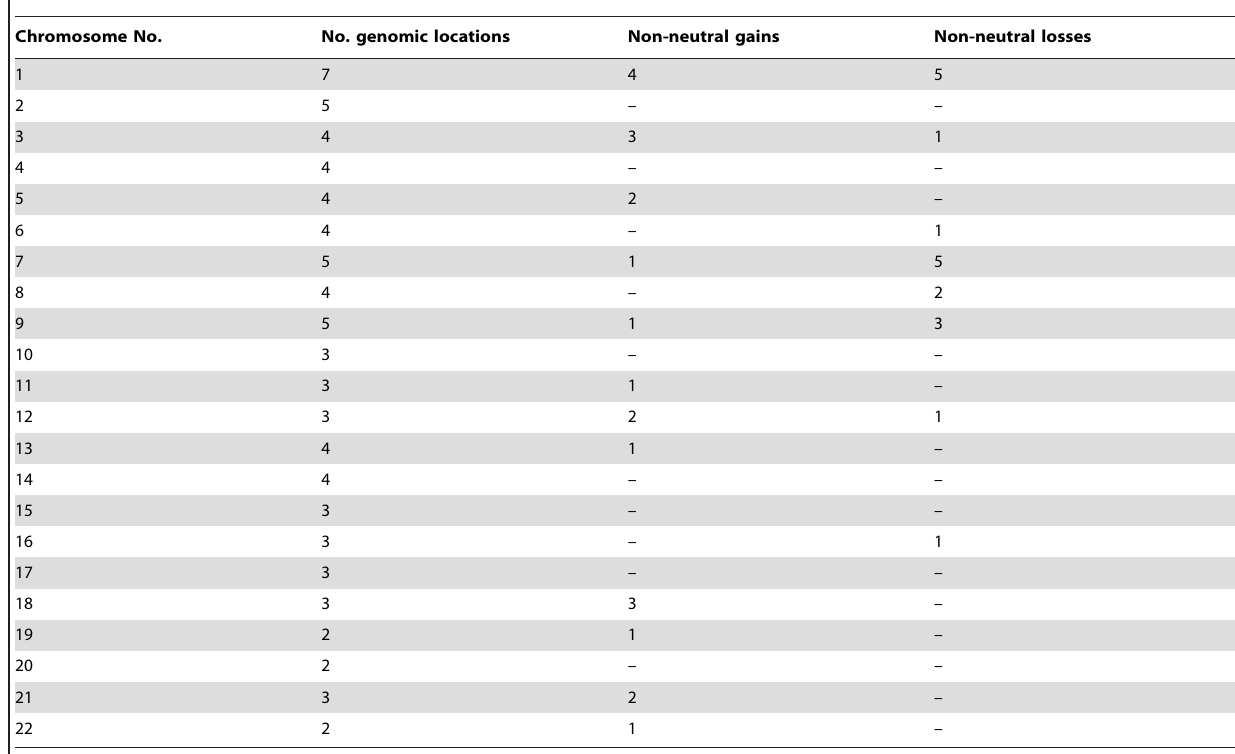
Table 1. Number of non-neutral regions per chromosome.